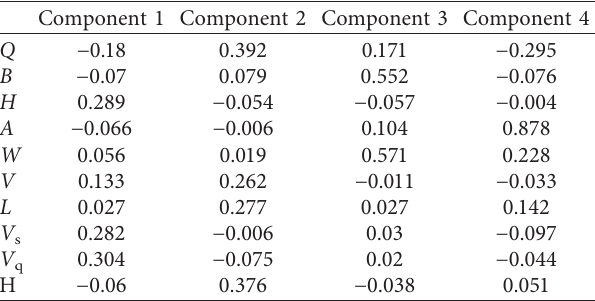
Table 4: Component score coefficient